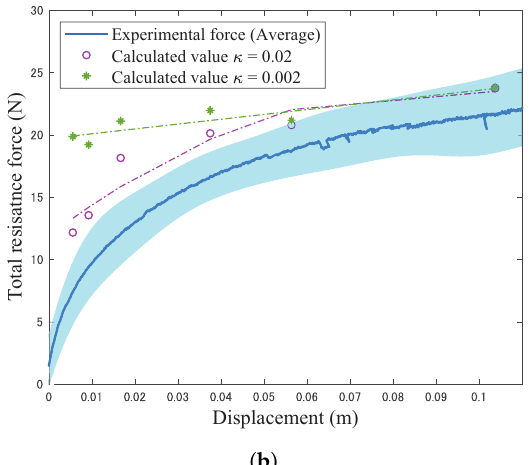
Figure 20. Calculated values that were obtained by the preliminary model vs. total resistance force that was obtained from the separate force sensor above the wheel unit. ( a ) Mean ± SD force vs. sinkage. ( b ) Mean ± SD force vs.